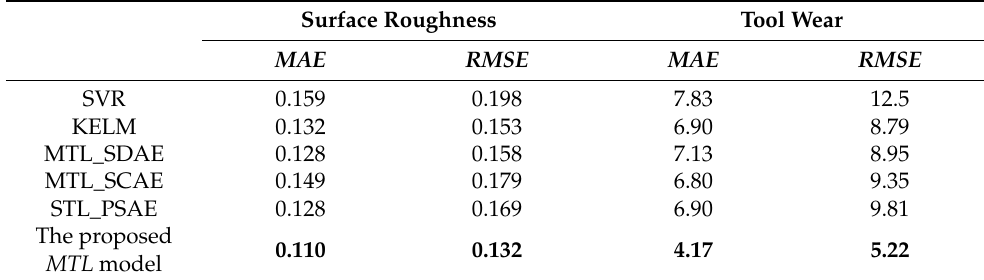
Table 8. Performance analysis of different